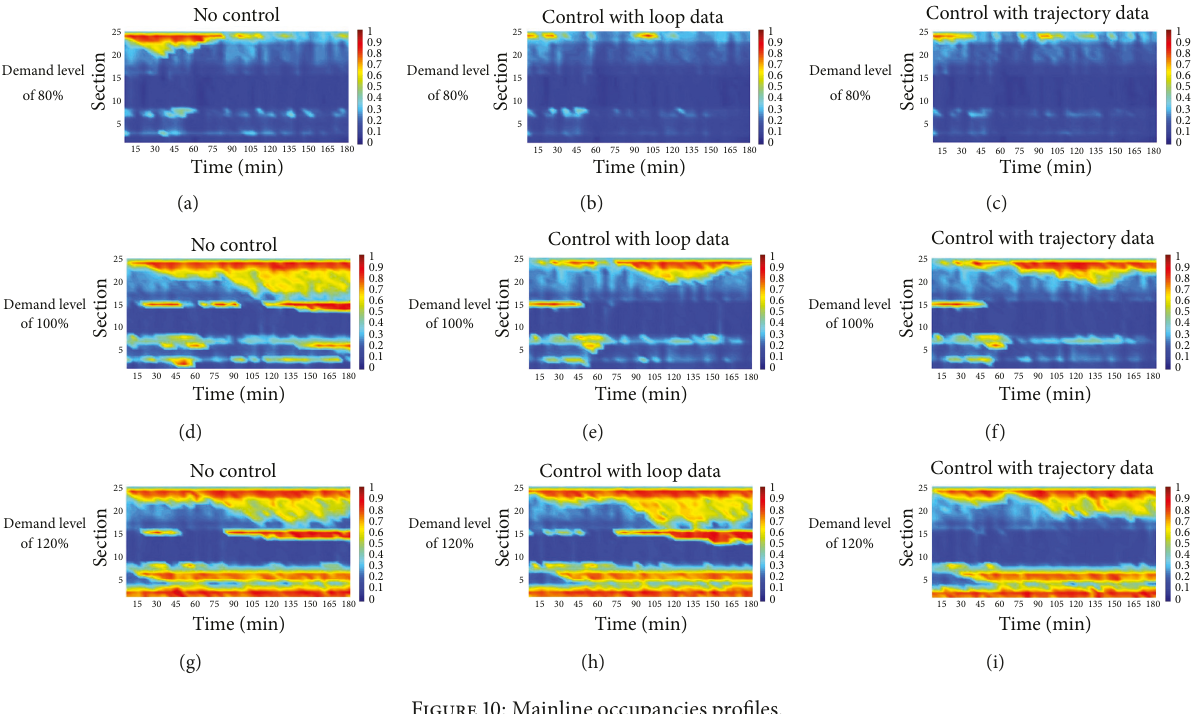
Figure 10: Mainline occupancies profiles.